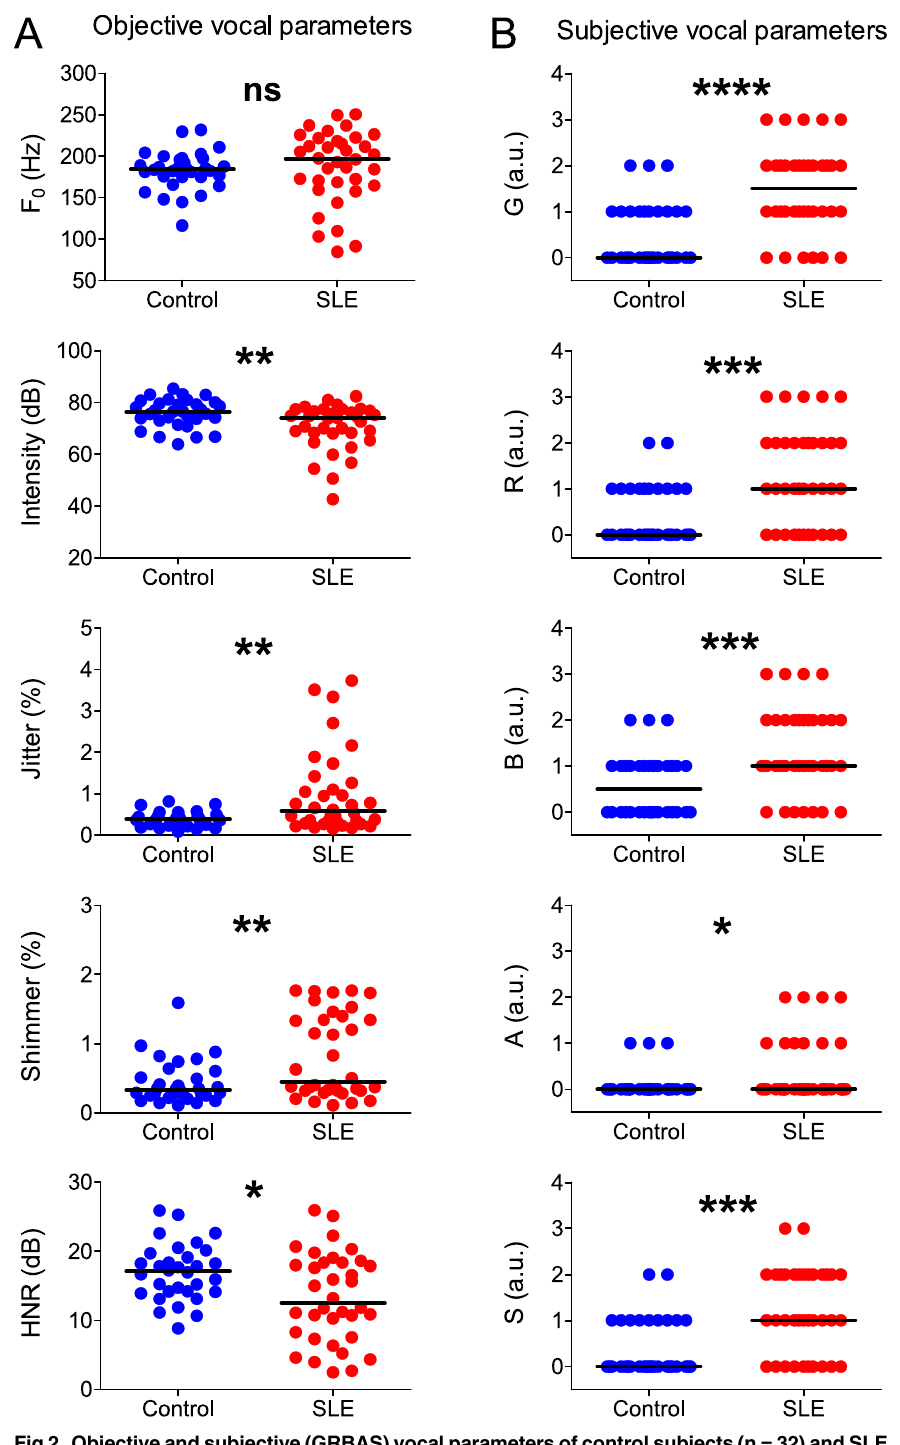
Fig 2. Objective and subjective (GRBAS) vocal parameters of control subjects (n = 32) and SLE patients (n = 36). Horizontallines represent the populationmedian.Each graph shows values for healthy controls and SLE patients of A: F 0 ; B: vocal intensity; C: jitter (main formant frequency variability); D: shimmer (intensity variability); E: HNR; F: G (generalgrade of dysphonia); G: R (roughness); H: B (breathiness); I: A (asthenia); J: S (strain); * = P < 0.05; ** = P < 0.001. *** = P < 0.0001.